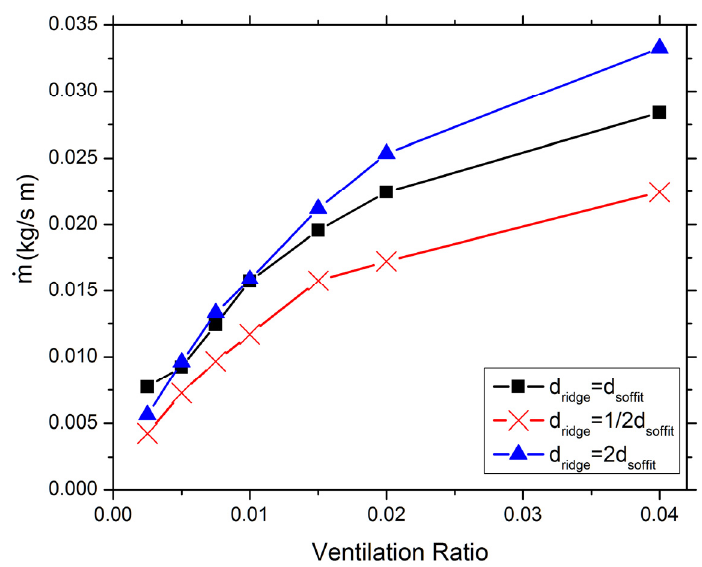
Figure 7. Predicted ventilating mass flow rate as a function of ventilation ratio for balanced and unbalanced attic ventilation cases.